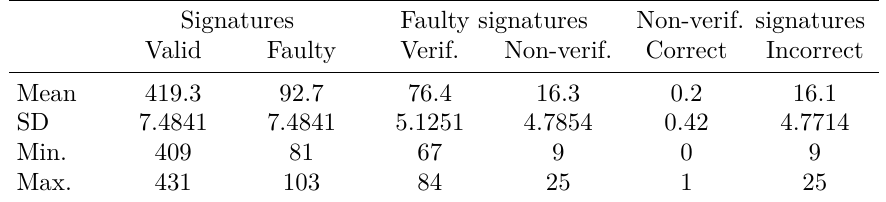
Table 16: Analysis of the collected signatures in N = 10 fault attacks against SPHINCS + - shake-256s-robust at layer l ∗ = 7 when 171 branches are cached.